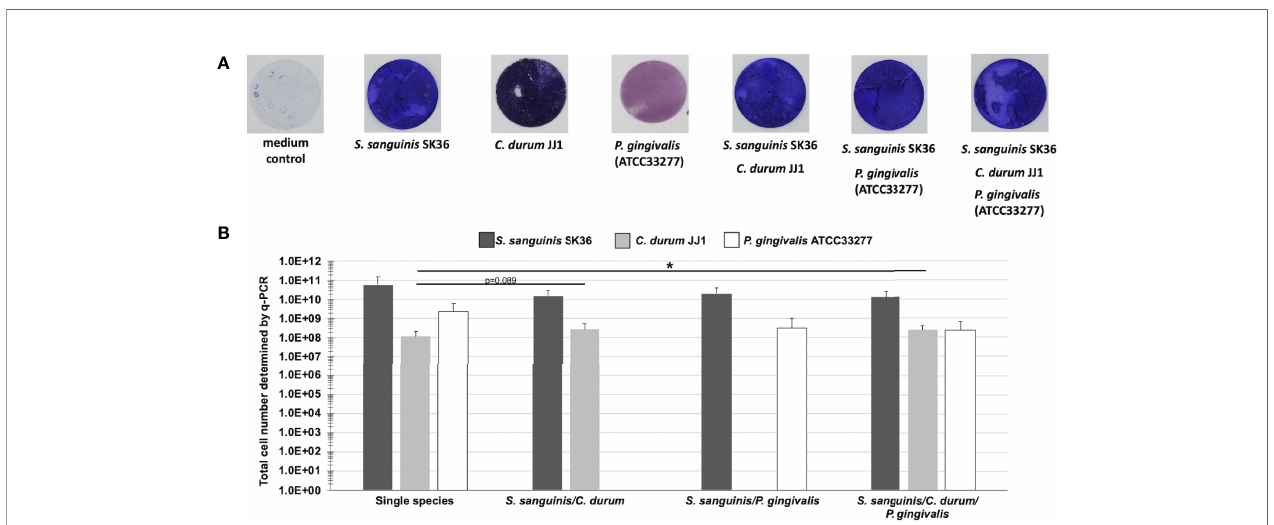
FIGURE 2 | Bio fi lm growth of single, dual, and multispecies of S. sanguinis , C. durum , and P. gingivalis on Thermanox coverslips. (A) Bacterial biomass of bio fi lms grown on Thermanox coverslips for 3 days was visualized with crystal violet staining. A Thermanox coverslip incubated in medium only served as the negative control. Pictures are representative of 3 biological replicates. (B) Determination of total cell numbers using q-PCR. Bio fi lms grown on Thermanox coverslips were removed and bacterial DNA was isolated. The number of bacterial cells was calculated based upon standard curves of serially diluted DNA. Data represent the averages and standard deviations of 3 biological replicates. (p-value indicated). *p < 0.05 (Students t-test, two-tailed,